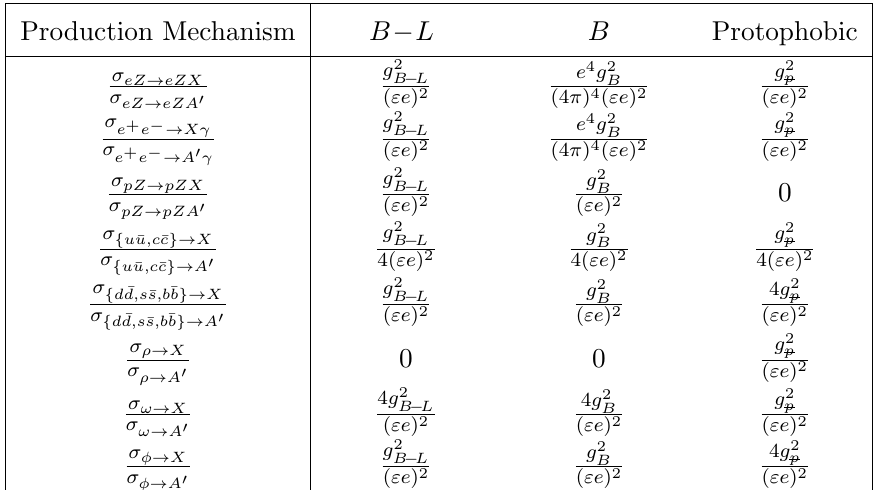
Table 1 . Couplings to SM fermions for the models studied in section 3.